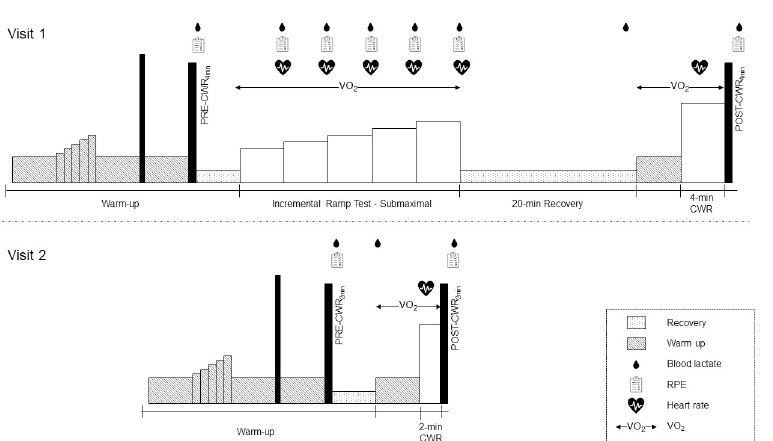
Fig 1. Outline of experimental protocol for the first and second visits to the